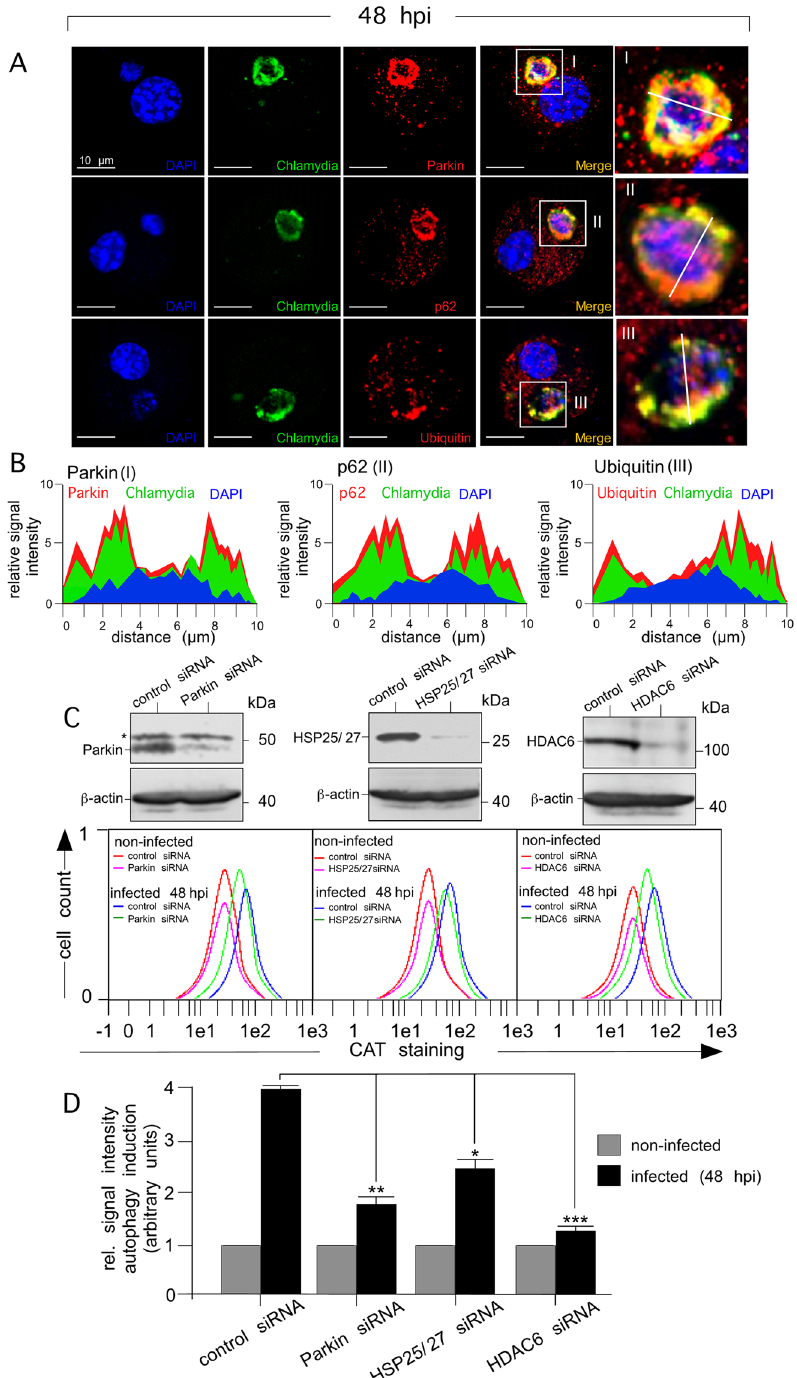
Figure 7. Silencing of aggrephagy-associated proteins affects the autophagosomal degradation of chlamydial structures in infected DCs. ( A ) Infected DCs (48 hpi) were costained for Parkin, p62, or ubiquitin (red), chlamydial structures (green) and DNA (blue) (left panel). Enlarged photographs (I, II and III, right panel) show colocalisation between aggrephagy-associated proteins and chlamydial structures. ( B ) The fluorescence intensity along a cellular cross section of interest was measured. Obtained profiles were overlaid and coloured. ( C ) DCs were siRNA-silenced for Parkin, HSP25/27 and HDAC6 and then infected (48 hpi) with chlamydia. siRNA silencing of Parkin, HSP25/27 and HDAC6 was demonstrated by Western blot (upper panels). Asterisk indicates an unspecific cross-reacting band. Autophagy induction in non-infected and infected (48 hpi) DCs (silenced for the different proteins) was analysed by CytoID staining (CAT). Fluorescence profiles were overlaid to directly compare changes in autophagy (lower panels). Data from three independent experiments (non- infected and 48 hpi) are summarised as bar graphs with arbitrary units ( D ). The value obtained for non-infected cells was set to 1. Statistical analysis in ( D ) was performed as described in Methods ( * p < 0.05; ** p < 0.01; *** p < 0.001 versus controls; n =